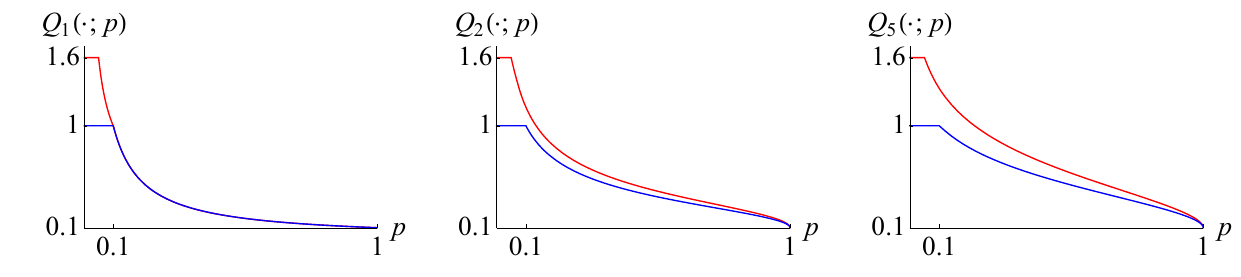
Figure 4. Sensitivity of Q (cid:32)` p, Q p X ; p α